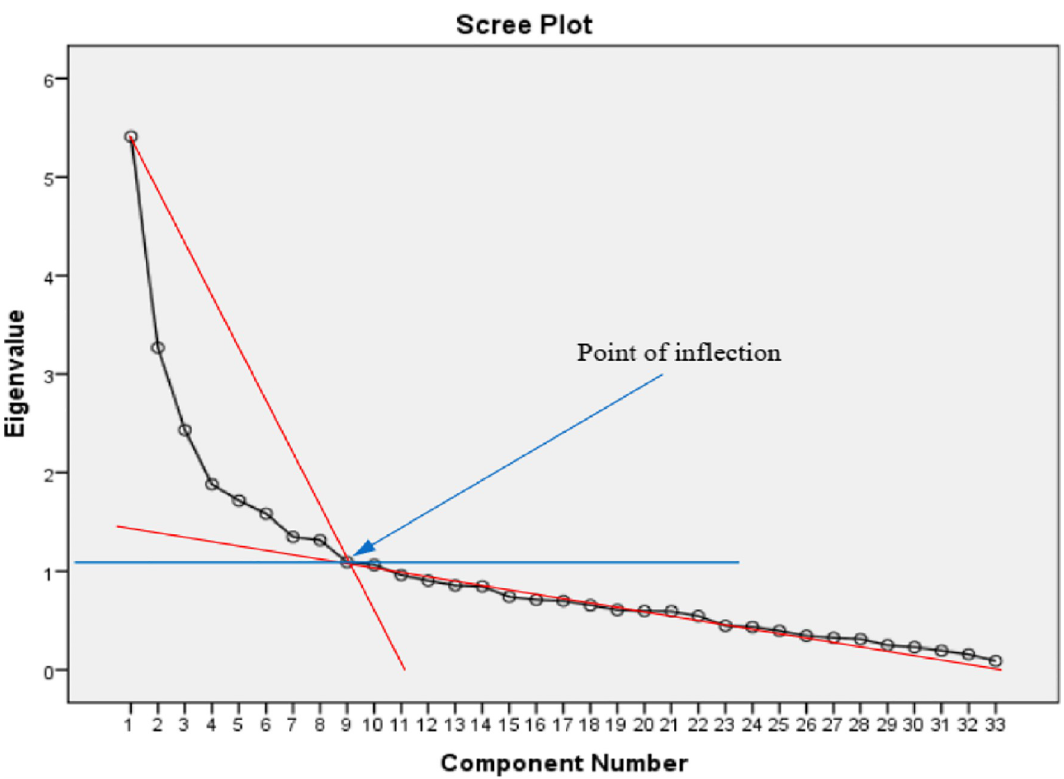
Fig 2. Scree plot showing the number of satisfaction components retained based on eigenvalue, December 2020.